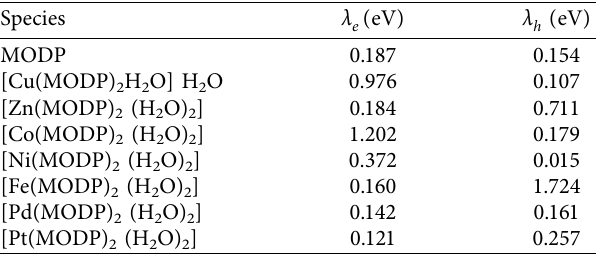
V e and h values of the different